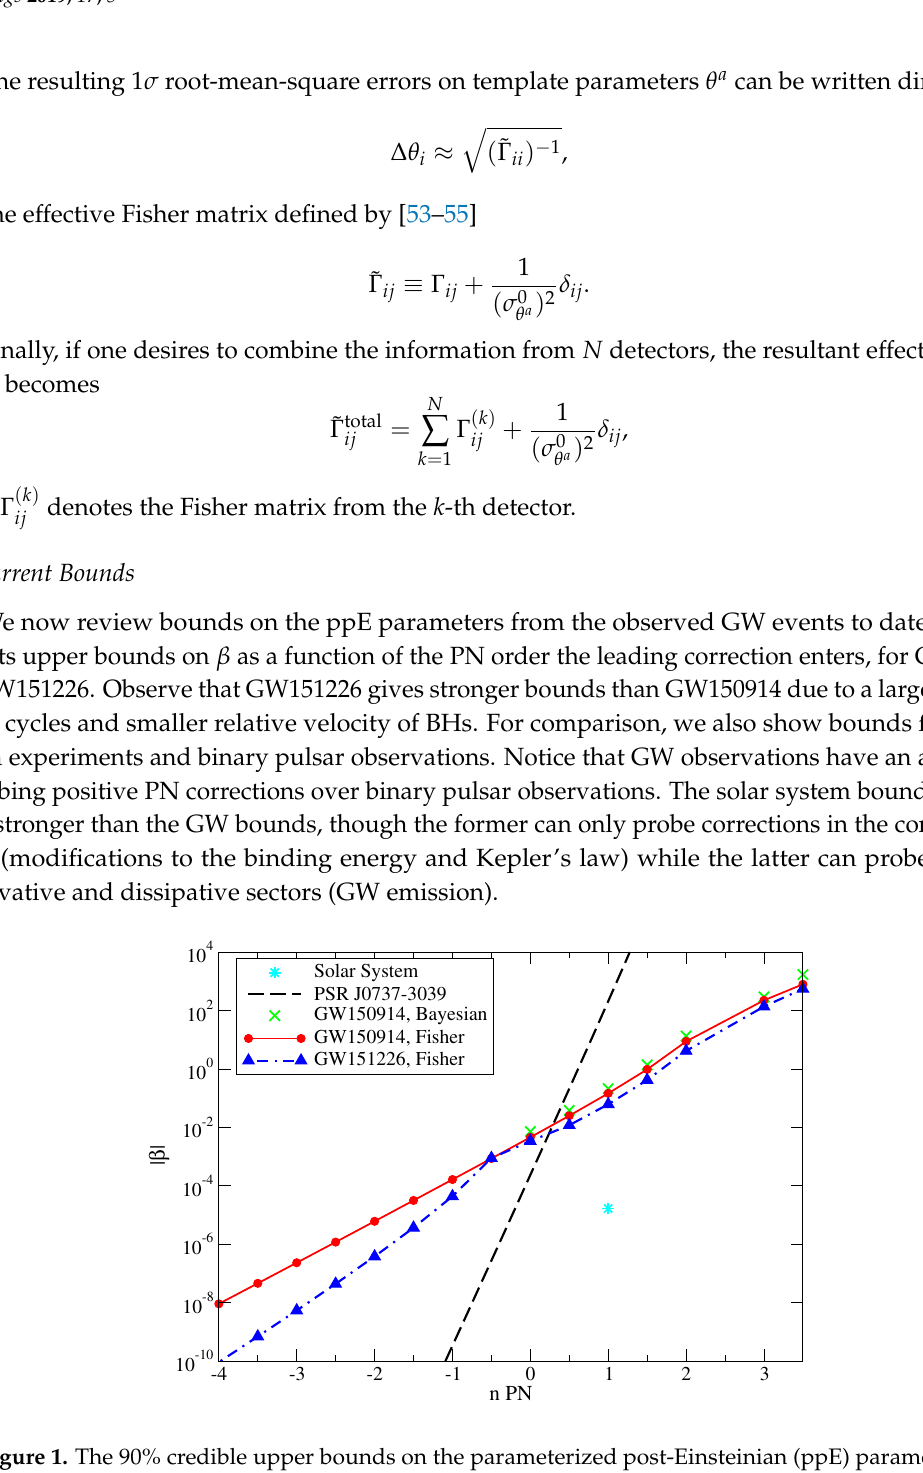
Figure 1. The 90% credible upper bounds on the parameterized post-Einsteinian (ppE) parameter β at each PN order the correction enters, using solar system experiments [56] (cyan star), binary pulsar observations [57] (black dashed), GW150914 with Bayesian [17] (green crosses) and Fisher [58] (red solid) analyses, and GW151226 with a Fisher analysis [58] (blue dotted-dashed). This figure is taken from